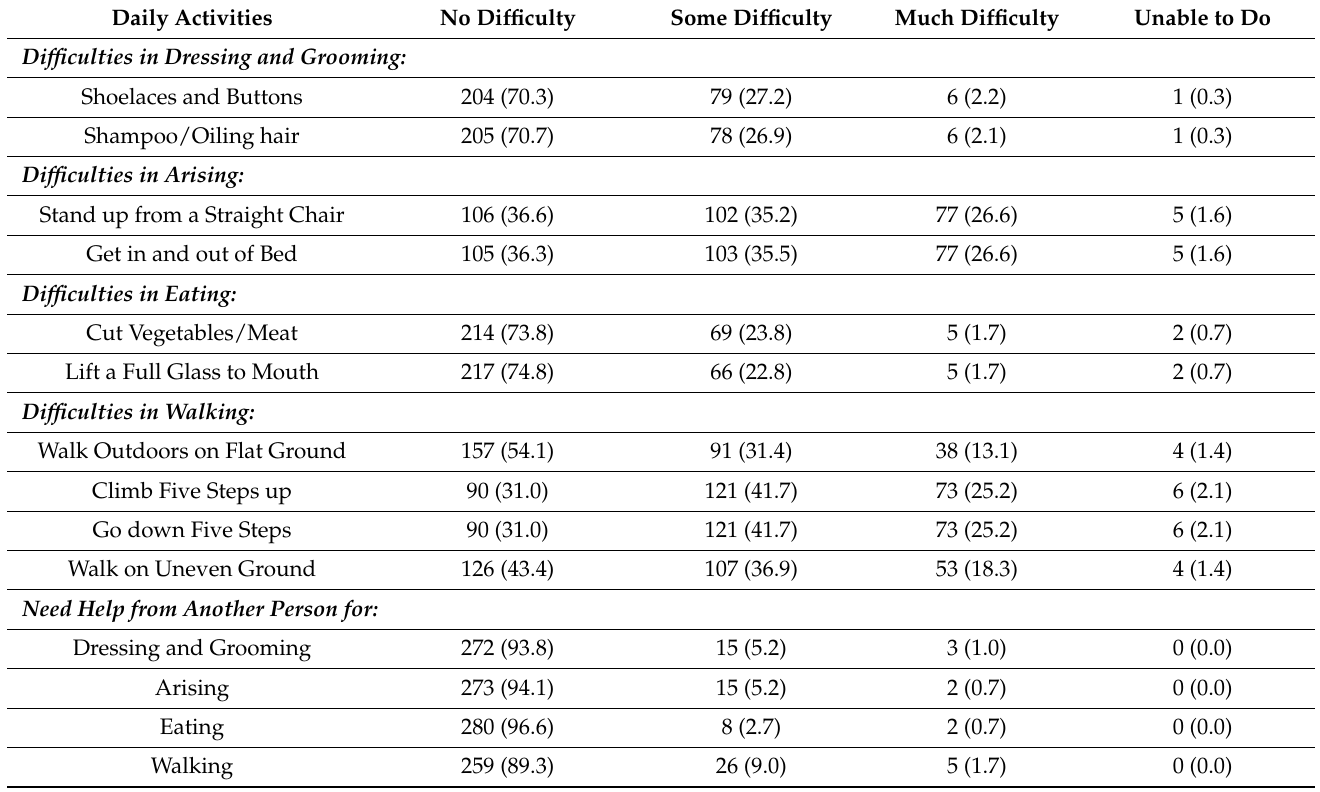
Table 3. Distribution of study subjects by difficulties in daily